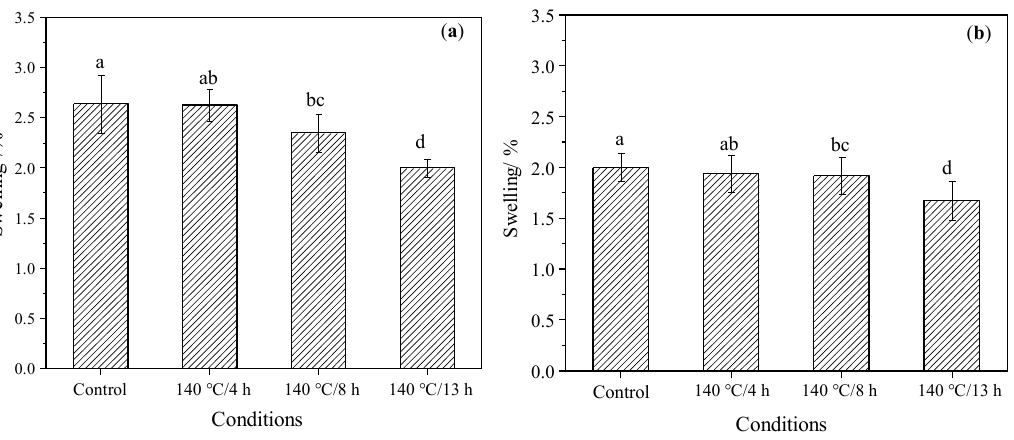
Figure 6. The swelling in the ( a ) tangential, and ( b ) radial direction of the control and modified wood after equalization in the conditioning chamber. Bars with different letters (left: a, ab, bc and d, and right: a, ab, bc and d) indicate significant differences ( p < 0.05) according to Duncan’s multiple range tests.